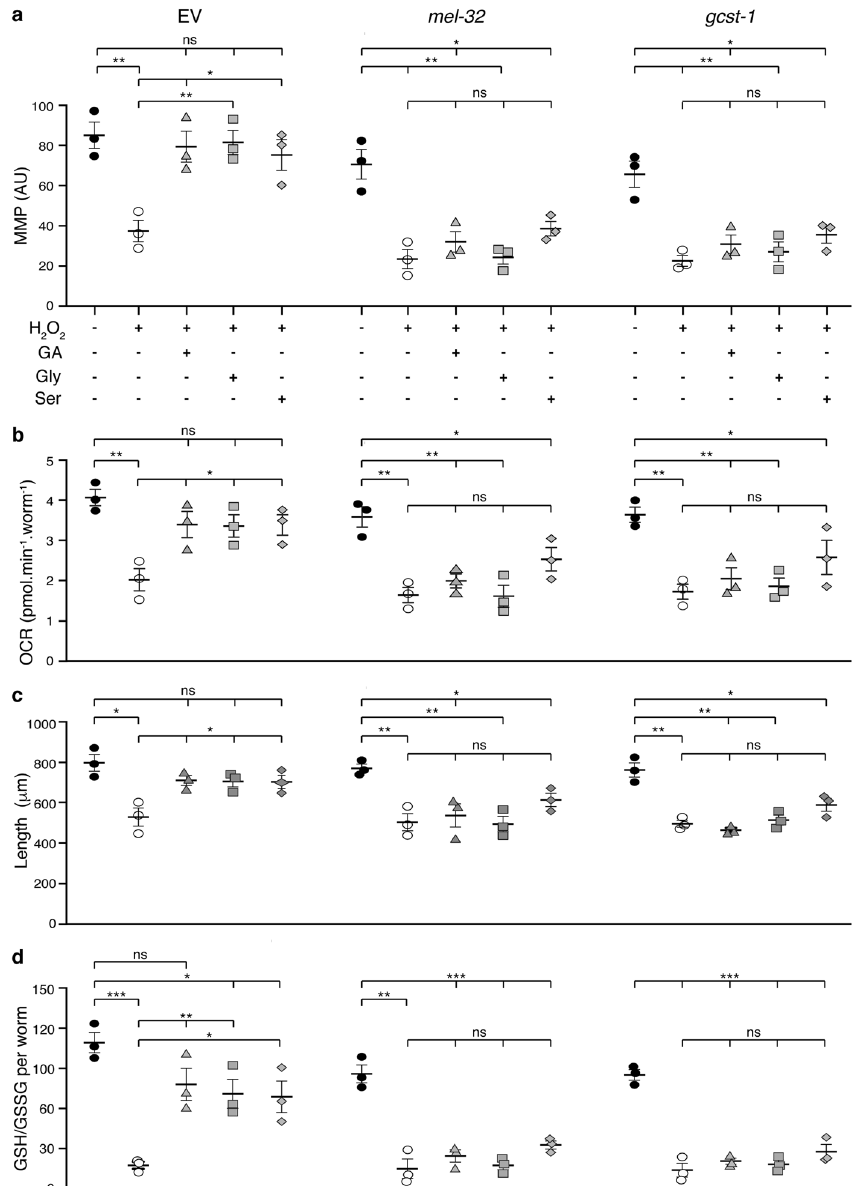
Fig. 7 SHMT and GCS activities are essential for the restoration of mitochondrial function and antioxidant capacity mediated by glycine, L -serine, and glycolate upon peroxide treatment. Mitochondrial membrane potential ( a ), respiration rates ( b ), size ( c ), and GSH/GSSG ratios ( d ) of wild type animals (N2) fed with empty vector (EV) or RNAi bacteria against mel-32 or gcst-1 genes exposed to 100 mM H 2 O 2 and supplemented or not with 10 mM glycolate (GA), 100 μ M glycine or 500 μ M l-serine. Measurements were carried out as described in Figs. 2 and 3. Error bars represent standard error of the mean ( n =